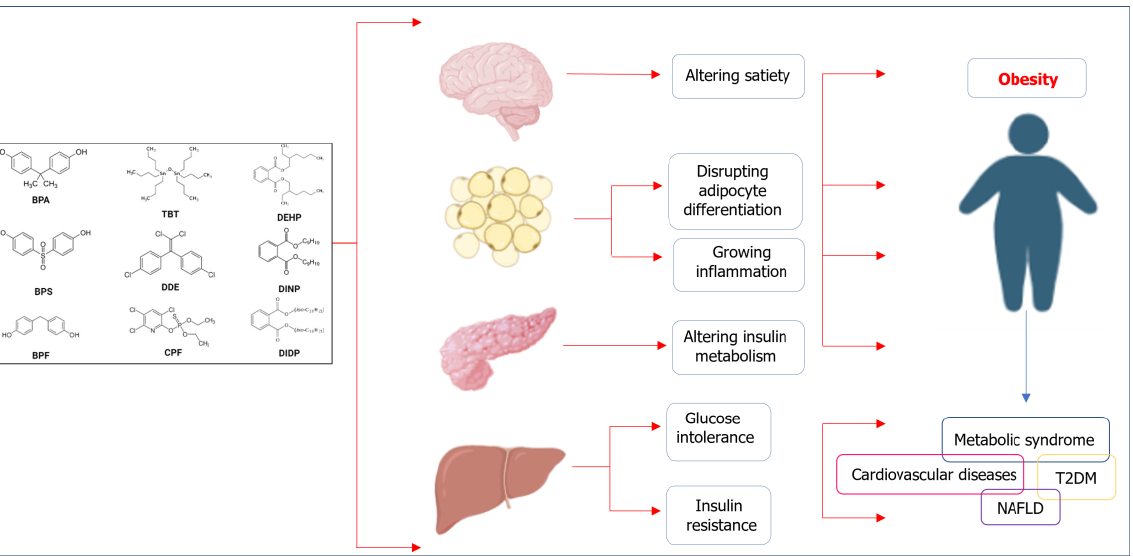
Figure 1. Summary of the effects of daily exposed obesogenic EDCs on crucial organs (liver and pancreas) and tissues (adipose and brain) and the relationship of these effects with human obesity and diabetes. T2DM, Type 2 diabetes mellitus; NAFLD, non-alcoholic fatty liver